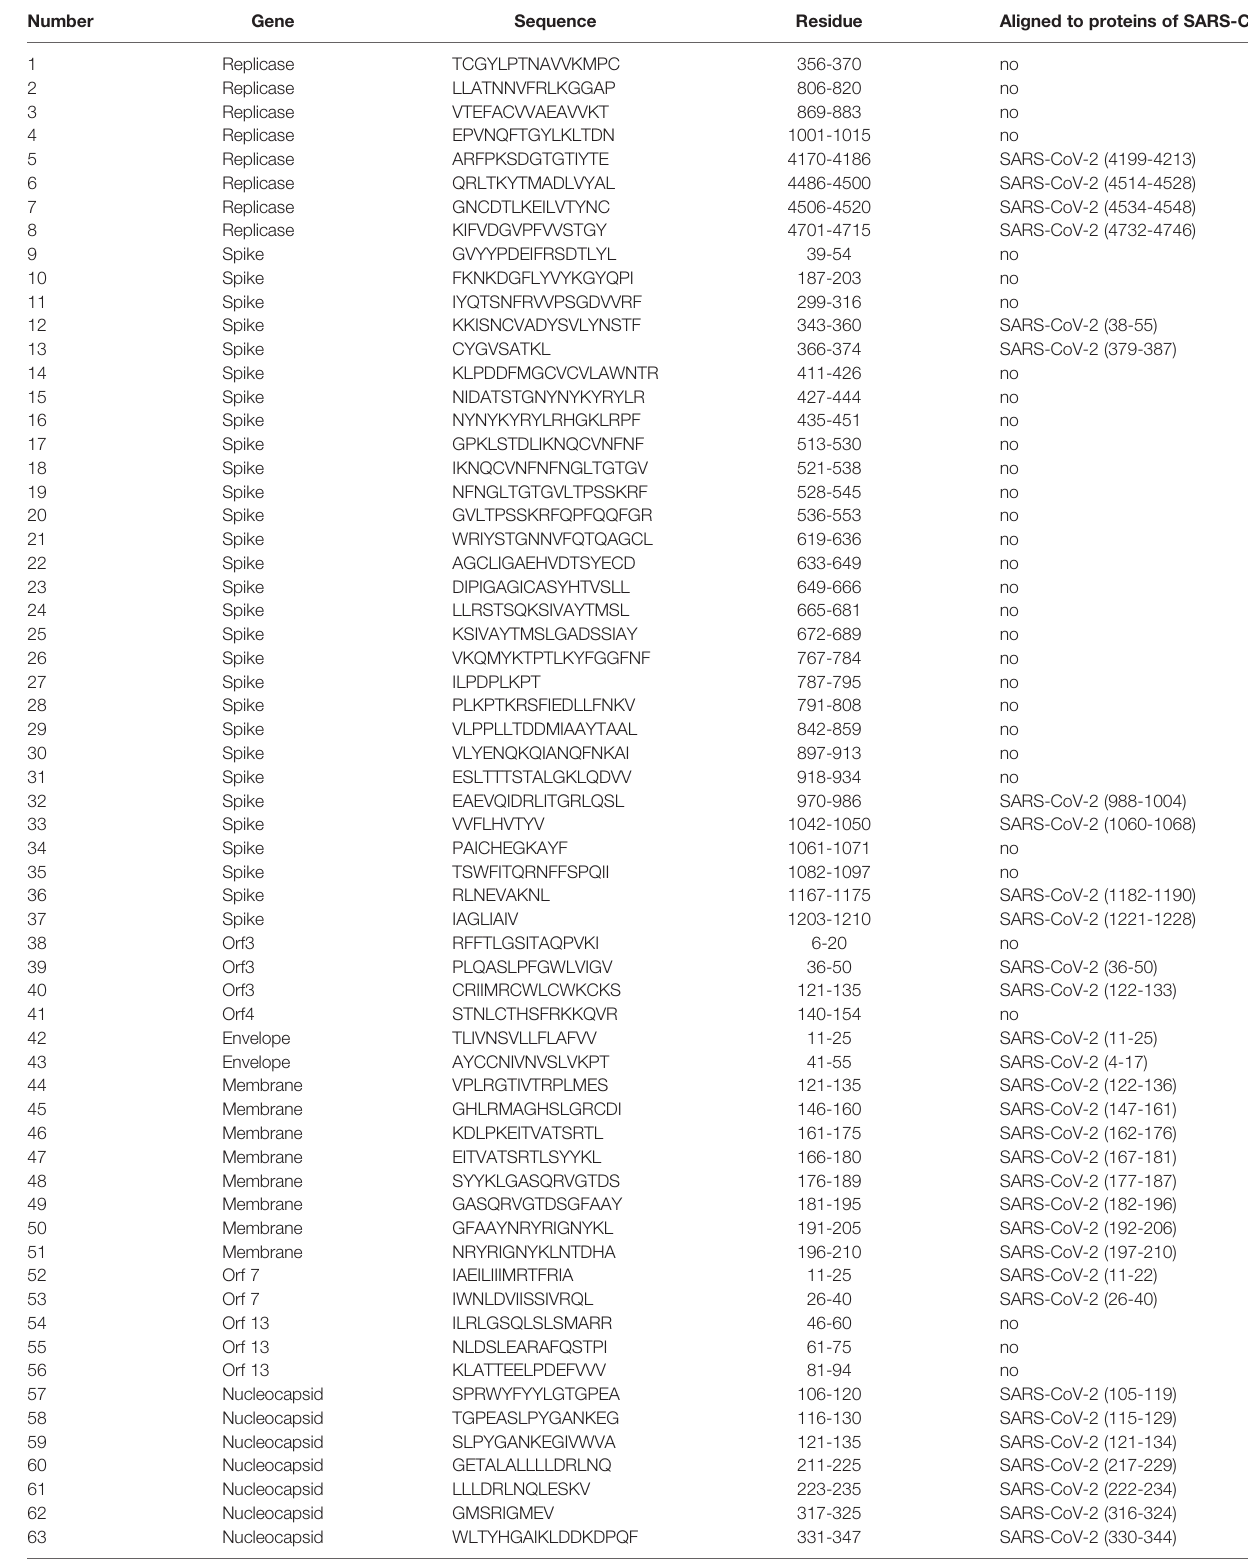
TABLE 3 | Synthesised SARS-CoV peptide epitopes and aligned to proteins of SARS-CoV-2. Number Gene Sequence Residue Aligned to proteins of SARS-CoV-2